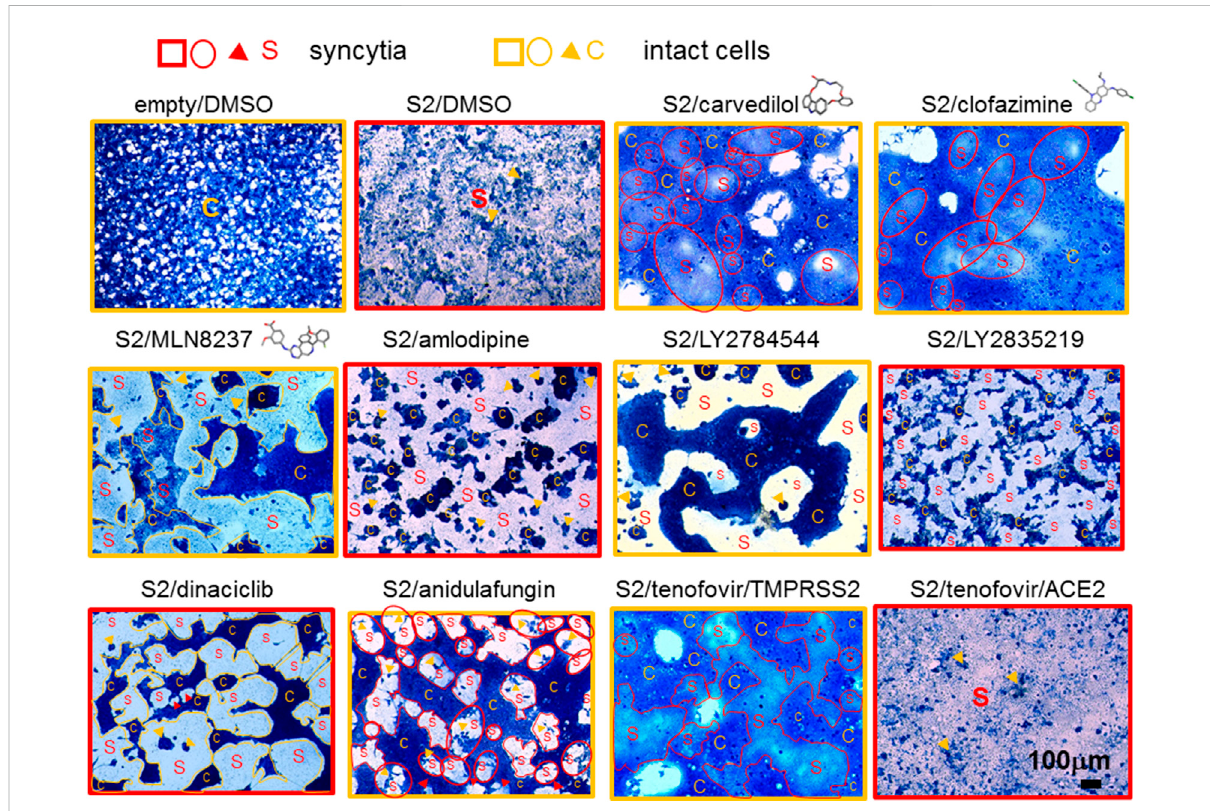
FIGURE 8 Fusion cell morphology. 50,000 293T-ACE2-TMPRSS2 pre-incubated with 10 μ M of individual drugs were co-cultured with 50,000 donor 293Tcellstransfectedwith anemptyvector ortheSARS-CoV-2 spikeprotein(S2).293T-ACE2 cells treatedwithtenofovirdisoproxilfumarate under physiologicalpHwasdisplayedatthebottomrightcorner;otherwise,allimagesrepresentfusionof293T-ACE2-TMPRSS2cells.Cellswere fi xedand stained with methylene blue. Bright- fi eld images areof thesame magni fi cation x100 and scale. Fieldsof entire or mostly syncytiaformation are framed with red squares. Fields of entire or moslty intact cells are framed with orange squares. Scattered syncytia are circled or outlined red and labelled S. Scattered intact cells are circled or outlined orange and labelled C. Sporadic intact cells and syncytia are marked by orange and red arrowheads, respectively. Drug images are from